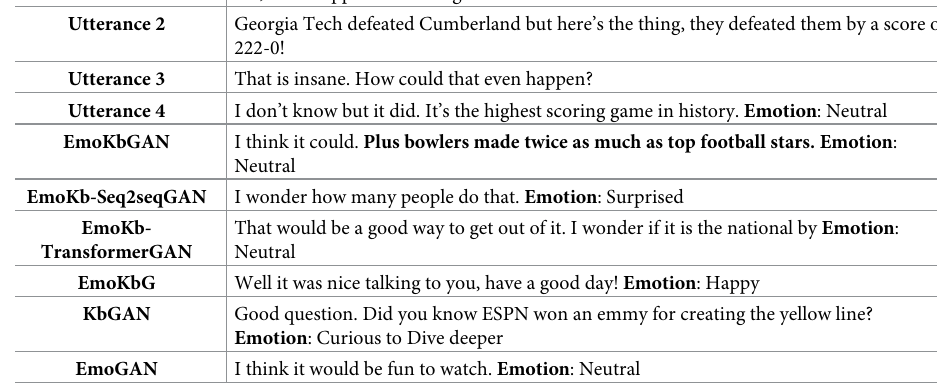
Table 8. Generated examples from our baseline, ablation and proposed models on the test set. Knowledge Base Football is a family of team sports that involve, to varying degrees, kicking a ball to score a goal. Unqualified, the word football is understood to refer to whichever form of football is the most popular in the regional context in which the word appears. Sports commonly called football in certain places include association football (known as soccer in some countries); gridiron football (specifically American football or Canadian football); Australian rules football; rugby football (either rugby league or rugby union); and Gaelic football. These different variations of football are known as football codes. the University of Iowa’s locker room for visiting football teams is completely painted pink in the 1960’s top bowlers made twice as much as top football stars —That the highest score ever in a football game occurred in 1916 when Georgia Tech defeated Cumberland 222-0 ESPN won an emmy for the creation of the superimposed yellow line representing the first down line for American football games. Former Partiots RB BenJarvus Green-Ellis has never fumbled the football in his NFL